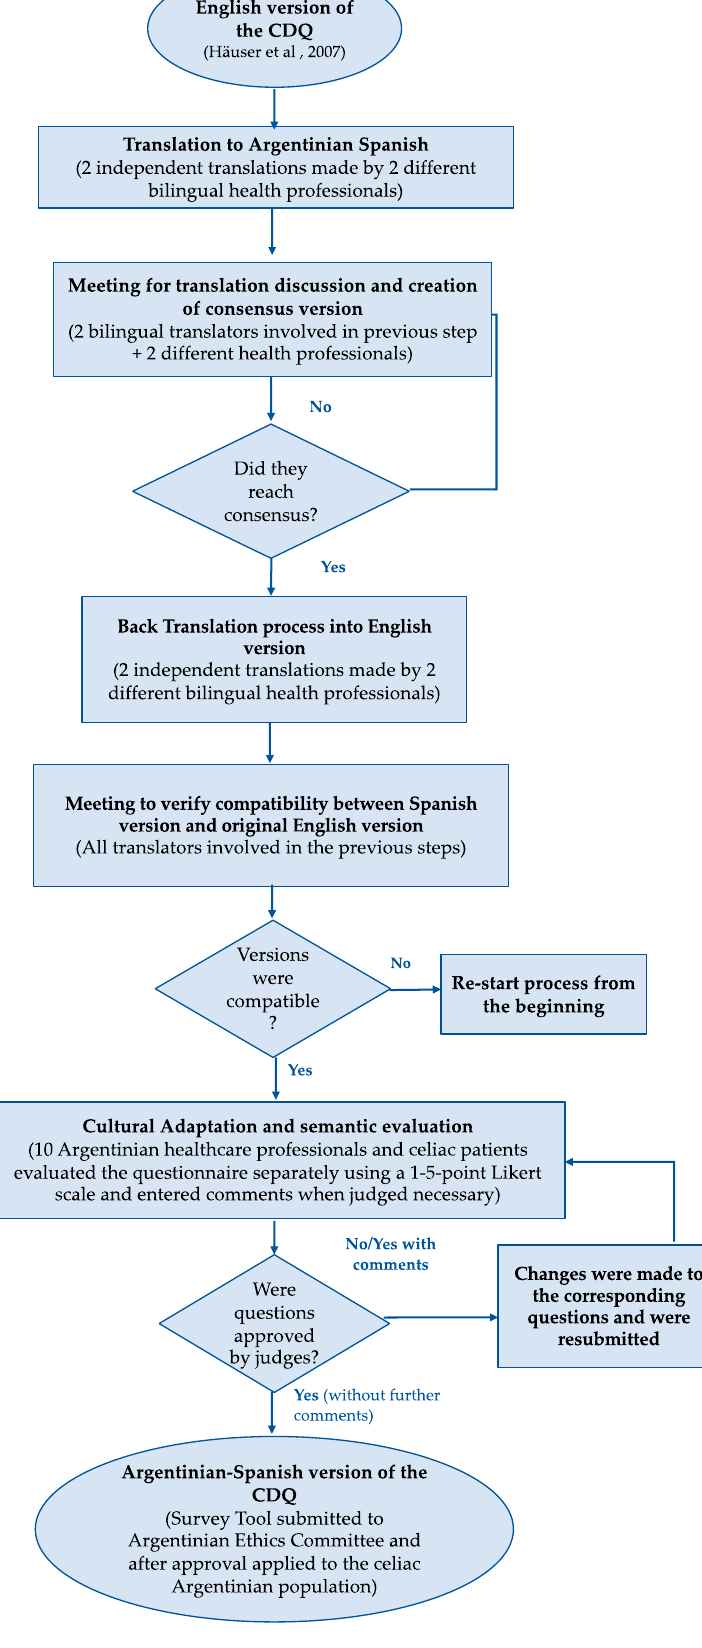
Figure 1. Flowchart of stages of the Argentinian-Spanish version of celiac disease questionnaire (CDQ).